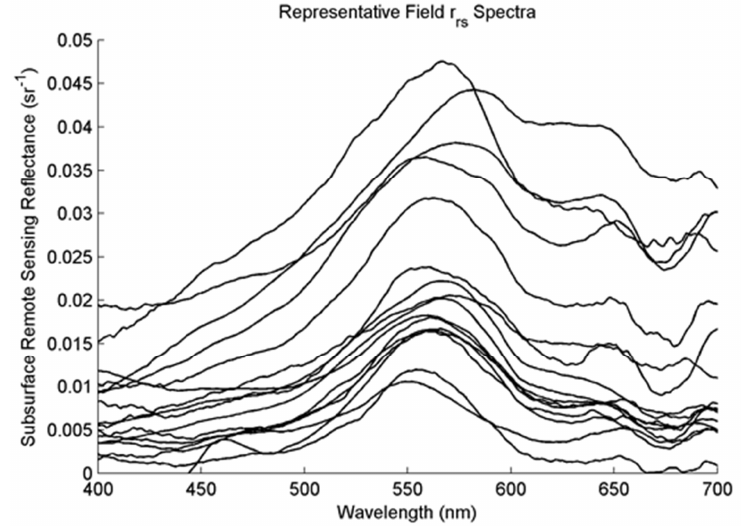
Figure 1. Representative r rs spectra in Singapore’s reservoirs. Spectra were drawn randomly from all collected spectra measured with an at-nadir view angle.